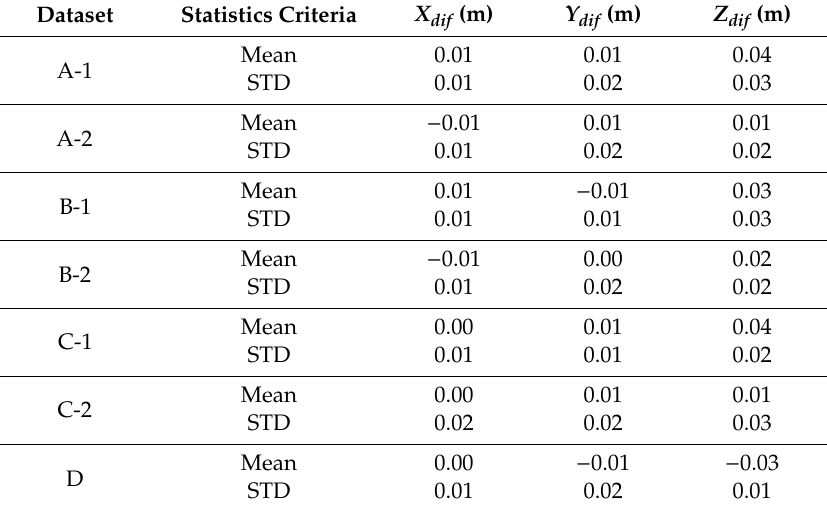
Table 8. Mean and STD of the di ff erences between estimated coordinates using the refined IOPs and RTK-GNSS measurements of the twelve targets for the seven datasets.